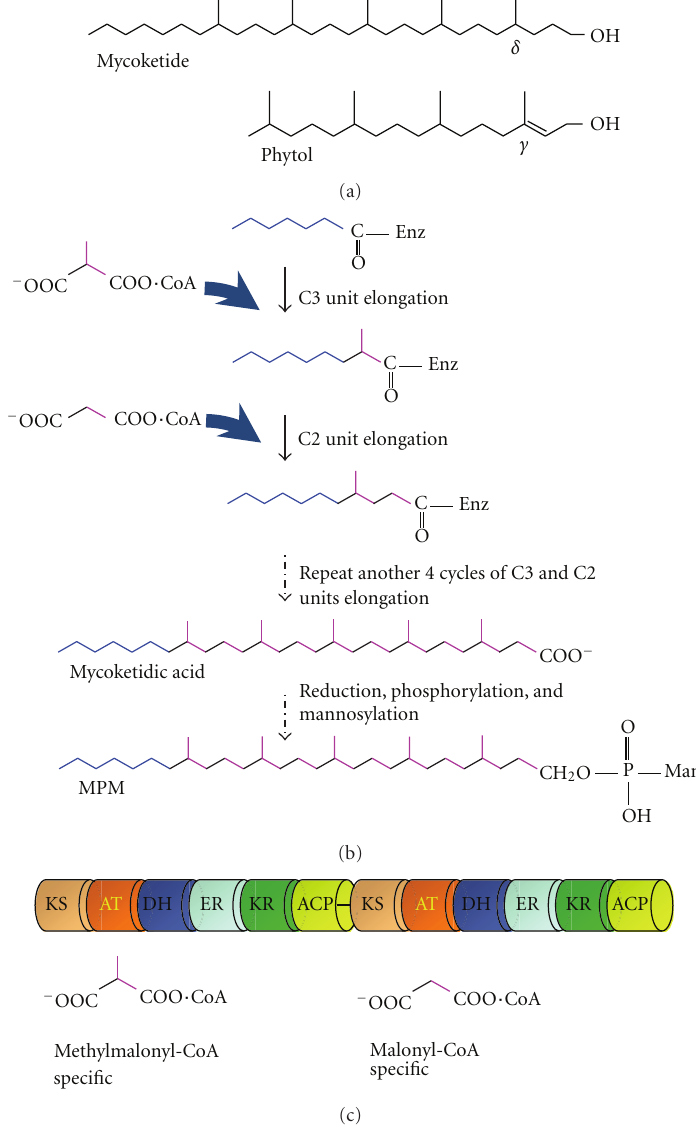
Figure 1: Biosynthesis of MPM. (a) Structures of mycoketide and phytol. Note that the first methyl branch of mycoketide is positioned at the δ -carbon whereas that of phytol, an isoprenoid compound, is located at the γ -carbon of phytol. (b) A predicted biosynthetic pathway of MPM. The chain elongation of mycoketide occurs on the Pks12 enzyme, followed by its release mediated by a yet unidentified hydrolase enzyme. (c) Schematic structure of Pks12 enzyme. Pks12 contains two tandemly aligned sets of catalytic domains (KS: ketosynthase; AT: acyltransferase; DH: dehydrogenase; ER: enoyl reductase; KR: ketoreductase; ACP: acyl carrier protein). The first set functions for a C3 unit elongation using methylmalonyl-CoA as a substrate and the second set for a C2 unit elongation using malonyl-CoA, which is controlled by the substrate specificities of the AT domains. Note that, unlike FAS enzymes, Pks12 lacks thioesterase